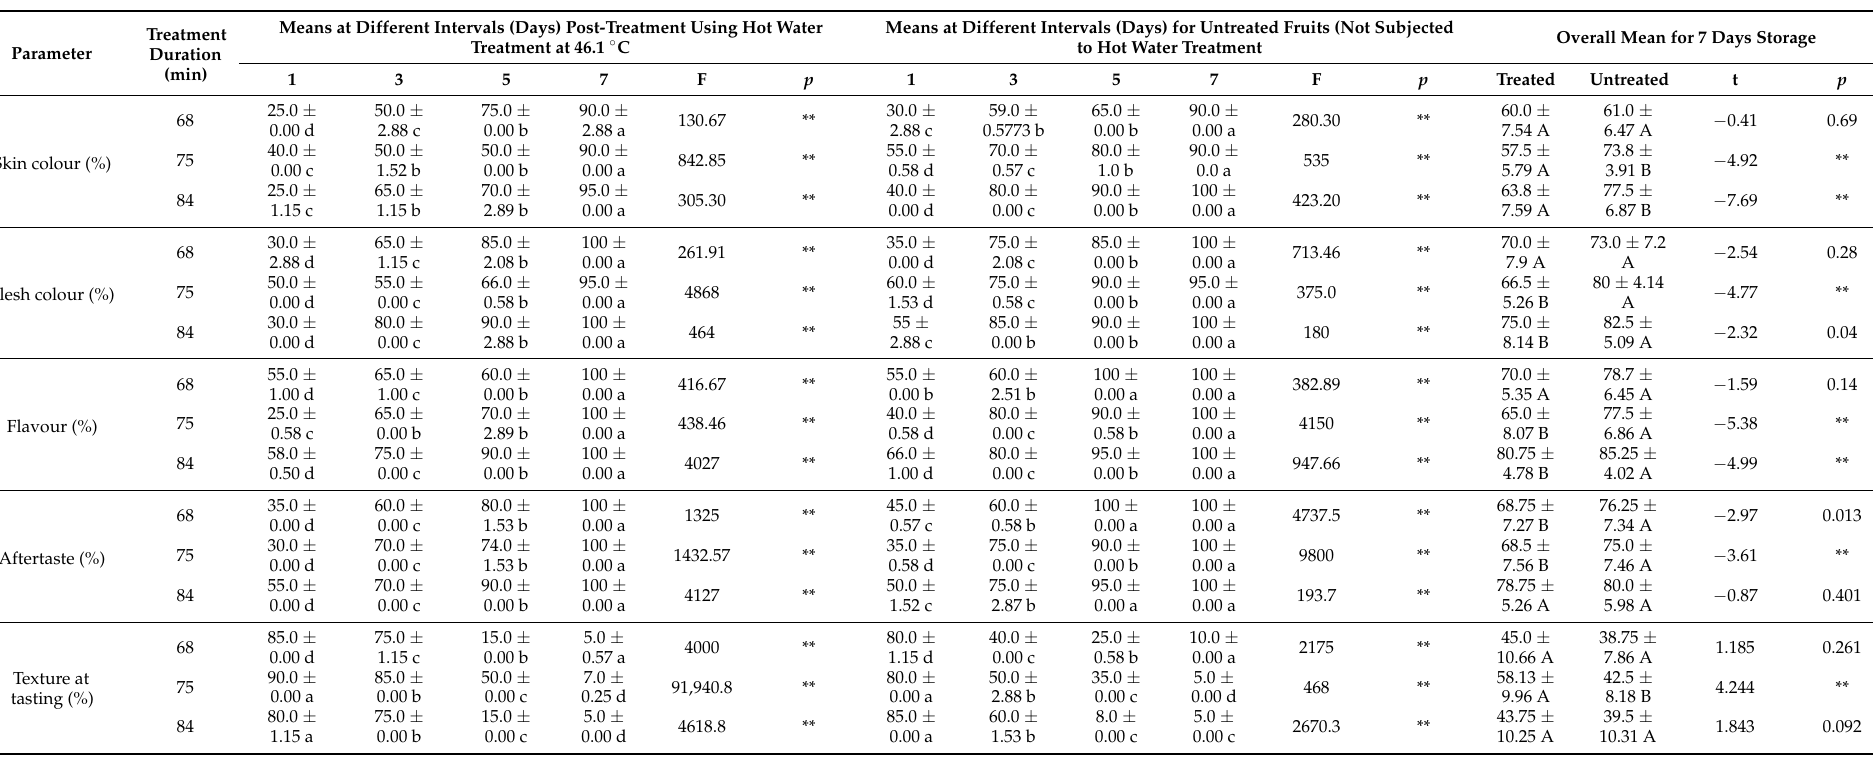
Table 7. Effect of hot water treatment at 46.1 ◦ C for different treatment durations on organoleptic properties of Apple mango cultivar stored over 7 days